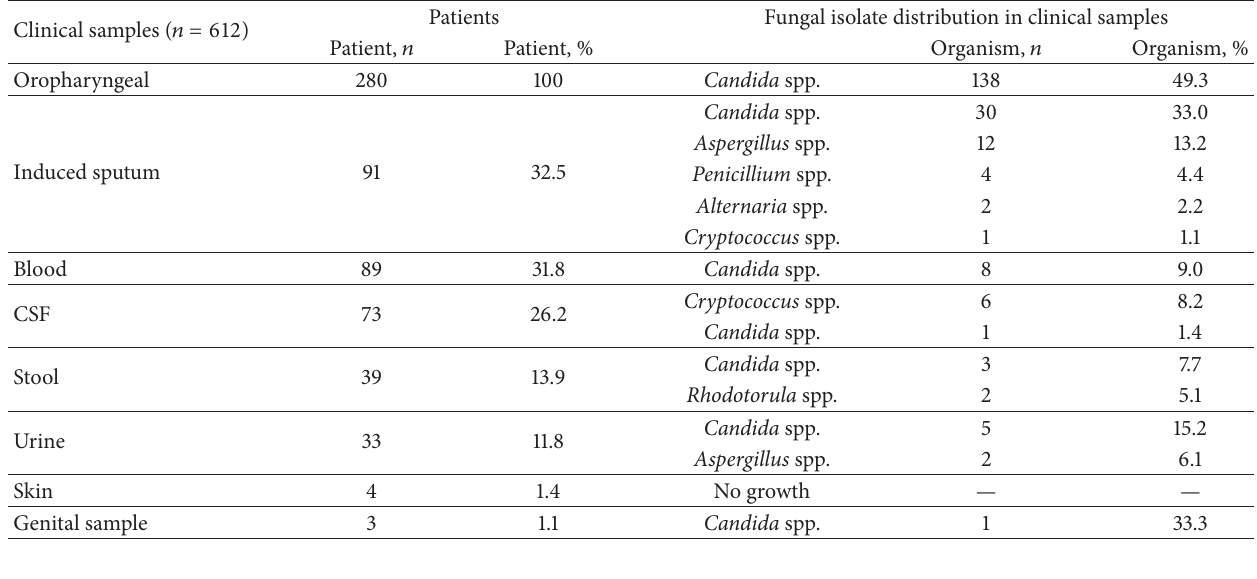
Table 3: Distribution of different fungal isolates among various clinical samples.